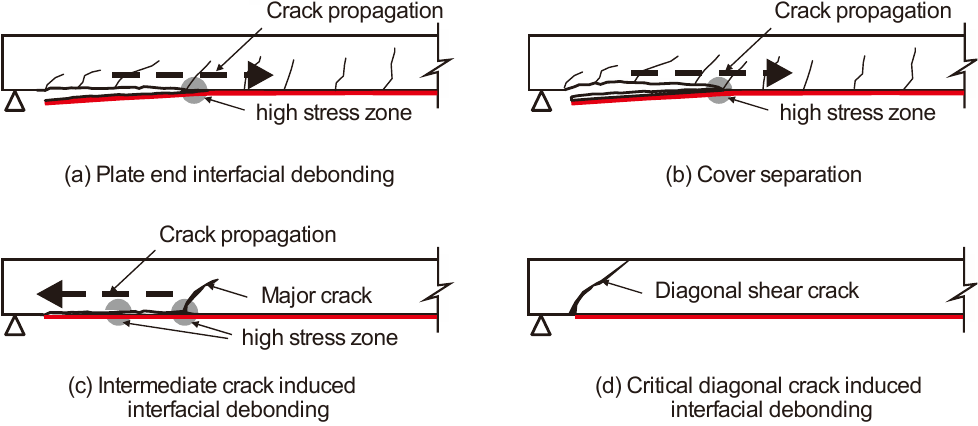
Figure 1. Typical EBR FRP debonding failure modes of RC slabs (adapted from [7]). ( a ) Plate end interfacial debonding; ( b ) Cover separation; ( c ) Intermediate crack induced interfacial debonding; ( d ) Critical diagonal crack induced interfacial debonding